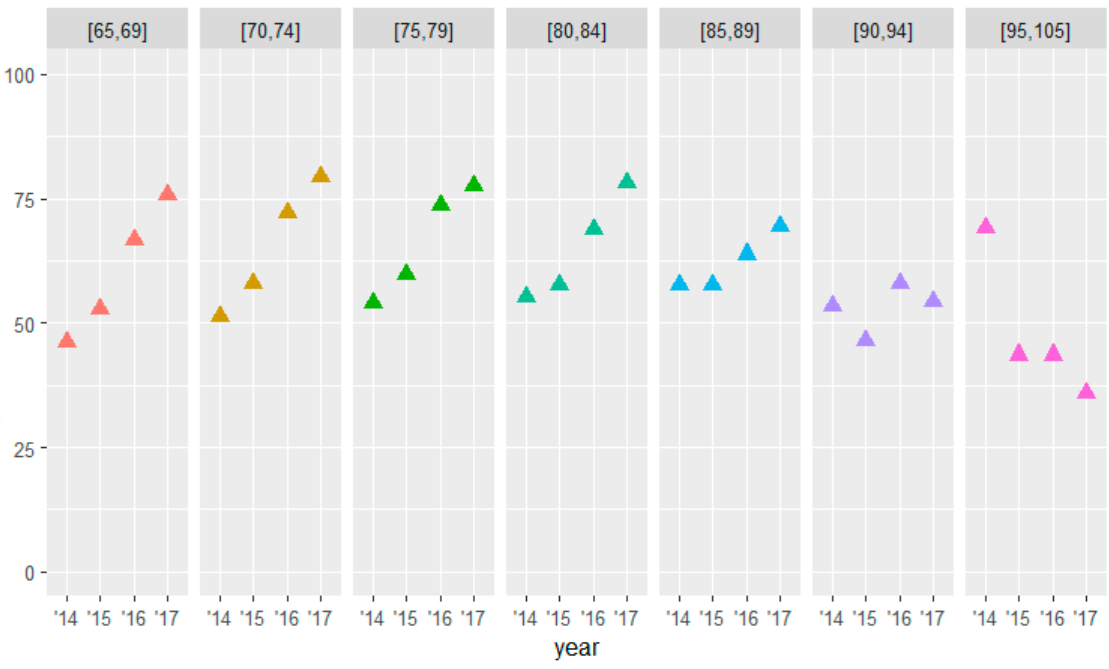
Figure 3. Influenza vaccination uptake by age at baseline ≥ 65 group (without chronic condition).